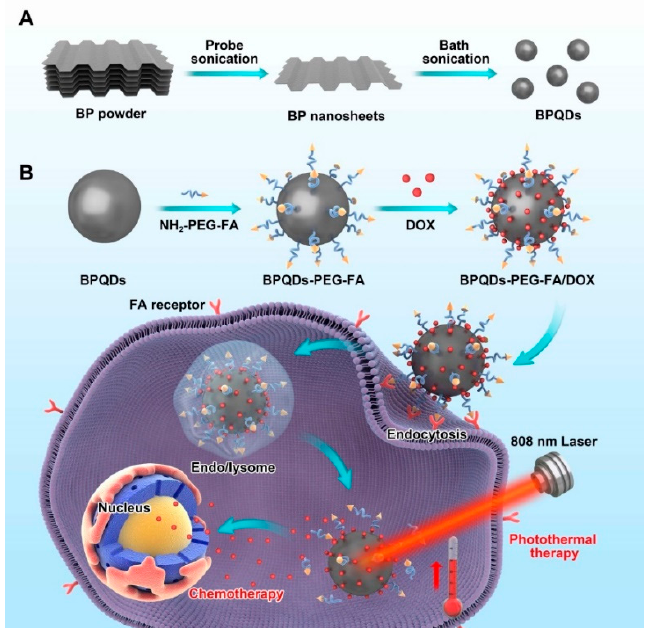
Figure 1. Schematic depiction of preparing black phosphorus quantum dots (BPQDs)-PEG-FA/DOX (doxorubicin) and their in vitro combined chemo-photothermal therapy. ( A ) Schematic illustration of the preparation of BPQDs; ( B ) Schematic illustration of BPQDs-based drug delivery system for synergistic photothermal/chemotherapy of cancer.